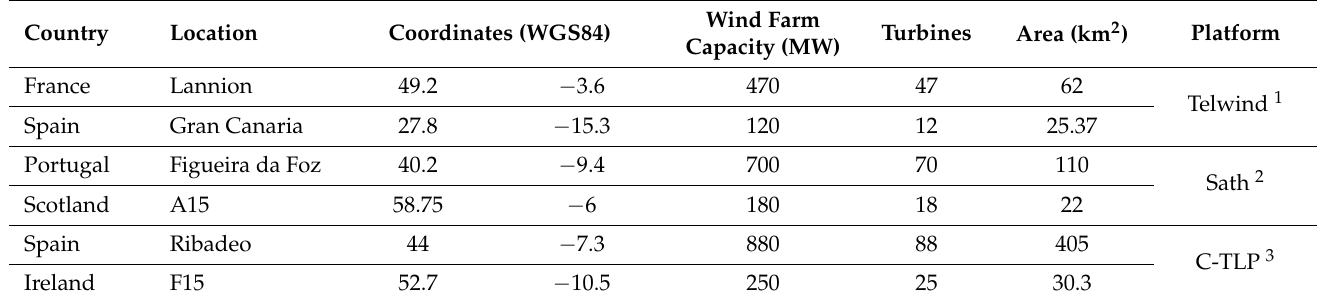
Table 5. Main floating wind farms proposed in the scope of the Arcwind